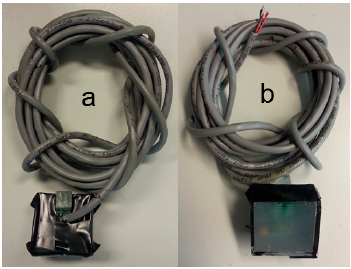
Figure 6 . ( a ) Back of the sensor; ( b ) Front of the sensor. Figure 6. ( a ) Back of the sensor; ( b ) Front of the sensor.